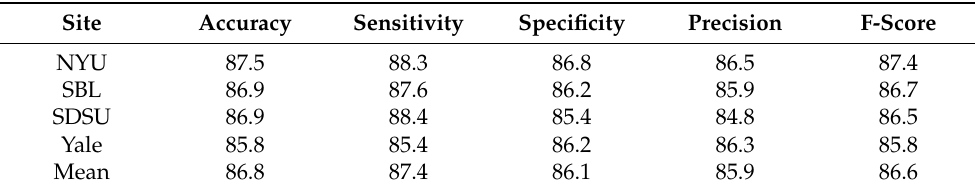
Table 5. Percentage of accuracy, sensitivity and specificity (in%) for binary classification, ASD vs. NC using leave-one site